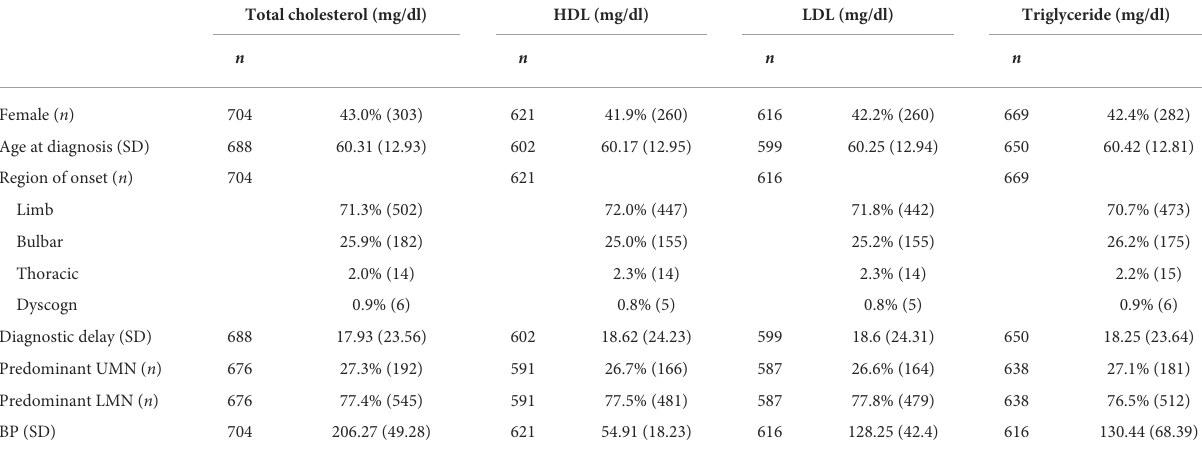
TABLE 1.2 Description of patient’s characteristics according to blood